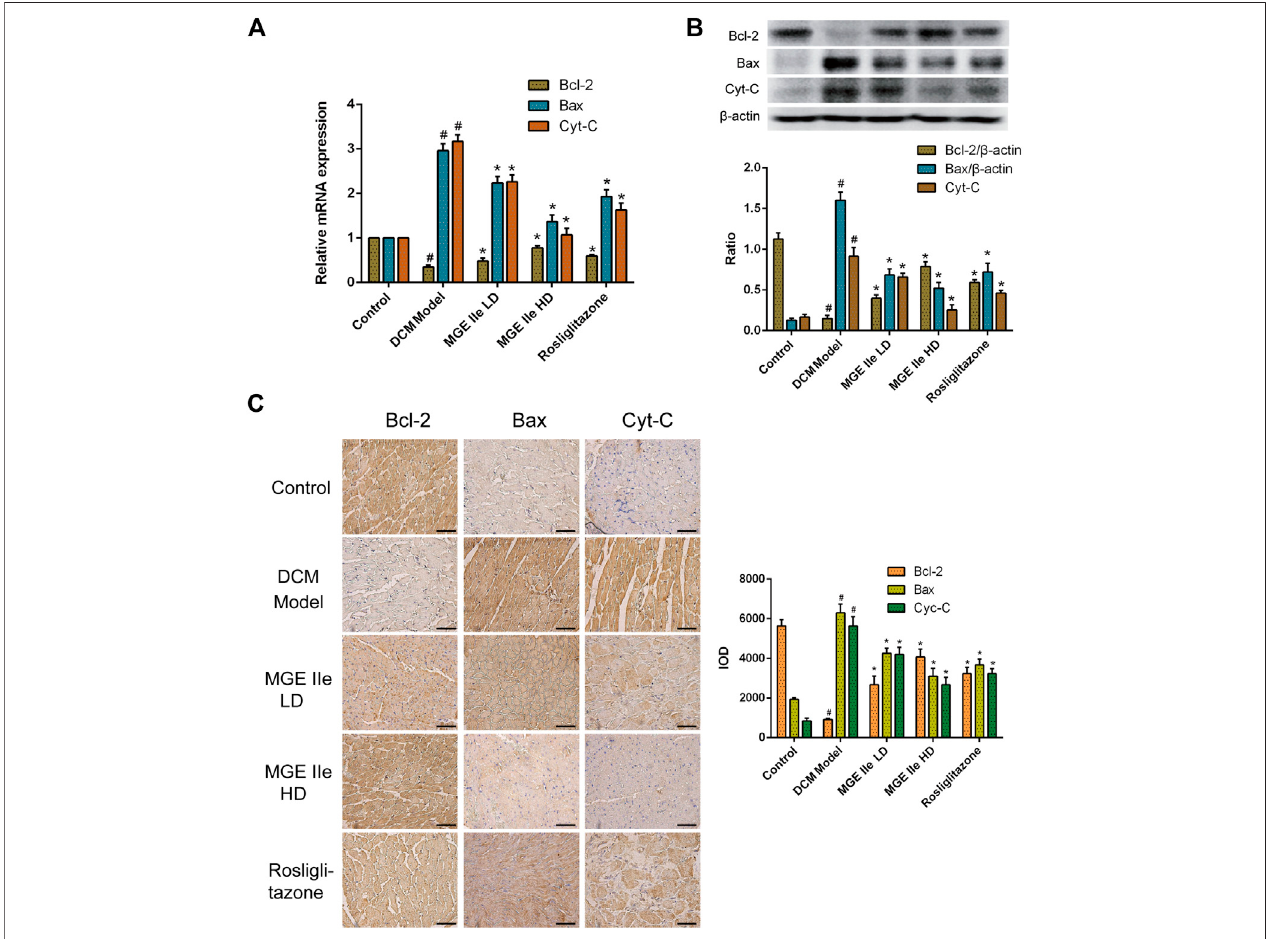
FIGURE3| MGEIIeinhibitstheexpressionofapoptoticfactorsBaxandCyt-CandpromotestheexpressionofBcl-2. (A) MGEIIeinhibitedthemRNAexpressionof Bax and Cyt-C, and promoted the mRNA expression of Bcl-2 as revealed by qPCR assay. (B) MGE IIe suppressed the protein expression of Bax and Cyt-C and promotedtheproteinexpressionofBcl-2asrevealedbywesternblotassay. (C) MGEIIesuppressedtheprotein expressionofBaxandCyt-Candpromotedtheprotein expression of Bcl-2 as revealed by IHC assay. Bar (cid:2) 50 µm. One-way ANOVA was followed by post hoc tests for comparisons among groups. The values shown represent the mean ± standard error of the mean (SEM) of the data from three independent experiments. # p < 0.05 (compared to the control group alone); * p < 0.05 (compared to the model group alone).